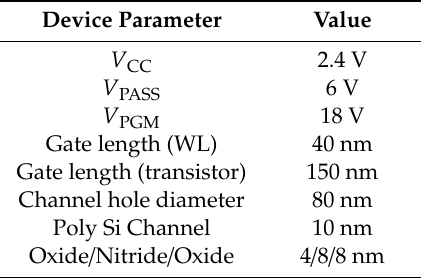
Table 1. Three-dimensional NAND device parameters, bias condition.